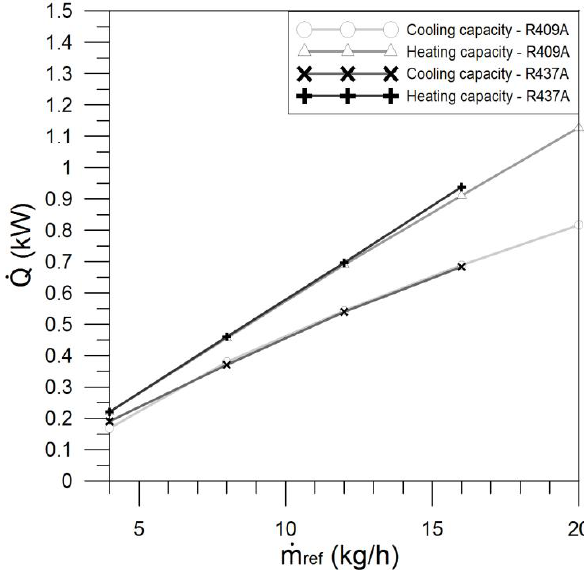
Figure 9: Effect of refrigerant flow rate on the cooling and heating capacities (Group B of